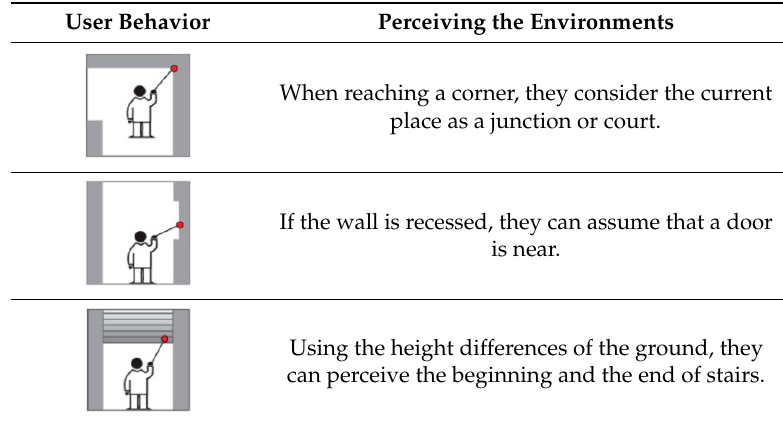
( c ) Figure 4. Visual clues used to guide pedestrians in real environments: ( a ) Place number; ( b ) Pictogram; ( c ) Guide sign. In addition, visual clues with positioning information were primarily observed in front of doors, while clues with directional information usually were observed in halls and corridors. For example, place numbers (Figure 4a) and pictograms (Figure 4b) were found in front of doors, whereas directional signs were found in a hall or at a junction shown in Figure 4c. In addition, in order to analyze the needs of blind people and visually impaired people for the proposed wayfinding system, we observed their behaviors in order to understand how they interpret the environmental information around them. Yang et al. studied their wayfinding behaviors through interviews and through capturing all actions during finding their destination in unfamiliar environments [40]. In general, the visually impaired people depend on white-cane to understand environmental information. Through alternatively striking the left side and the right side with the white cane, they can perceive the location of obstacles and the available directions toward their destination. Table 2 presents the user behaviors using the white-cane to understand the environment around them. On flat ground, the visually impaired people first find the nearest wall, and then move forward following the wall. When they move around, it is possible to recognize doors or corridors through changes in the edges and shapes of the walls. On stairs or slopes, they can determine whether to go up or go down through variations in the height of the ground. Table 2. Wayfinding behaviors of visually impaired people.